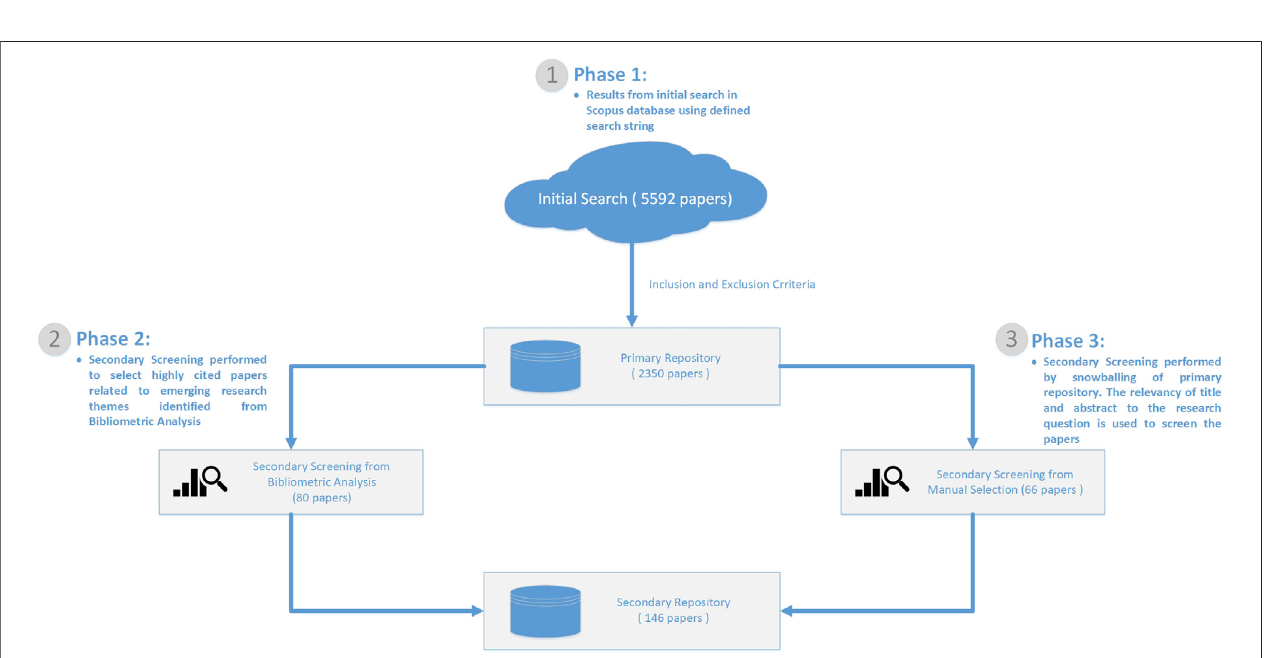
FIGURE 1 | Stages of review and the elimination of papers throughout the screening process.